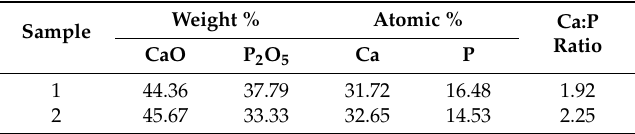
Table 2. Conversion of % oxide values to atomic %, and calculated Ca:P ratios.